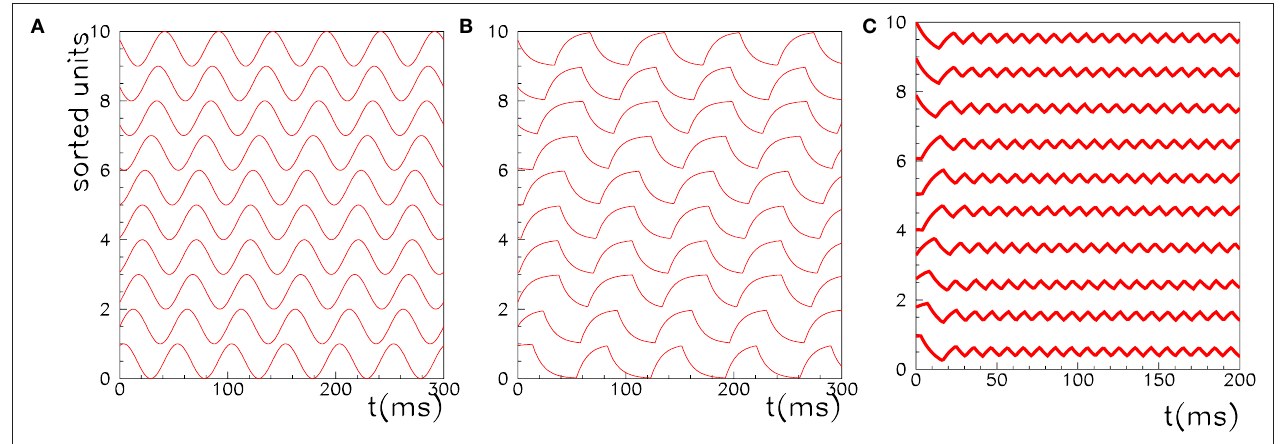
Figure 2 | The activity of 10 randomly chosen neurons in a network of N = 3000 fully connected analog neurons, with P = 30 stored patterns. The learning rule is given by Eq. (4) with ϕ * = 0.24 π . Neurons are sorted by increasing 1 of the first pattern, and shifted correspondingly on the vertical axis. (A) phase φ i The first stored pattern, that is the activity of the network given by Eq. (2) used to encode the pattern in the learning mode, with frequency ω